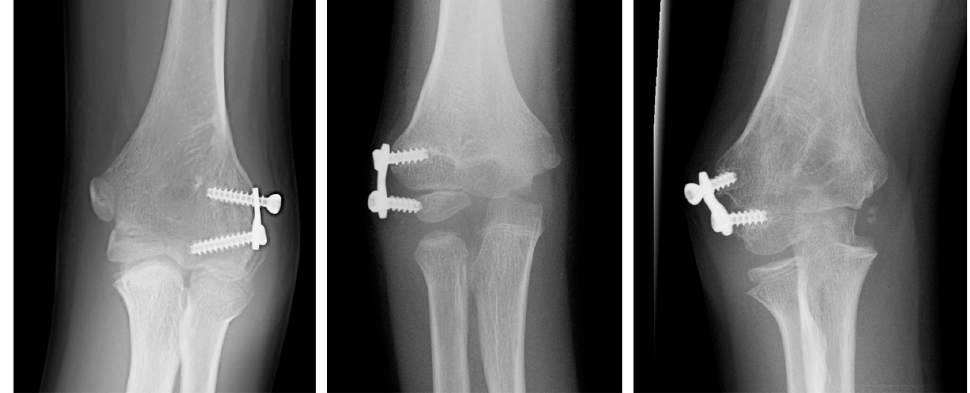
Figure 9. Radiographic images of some of the cases of aseptic loosening due to short screw length and a suboptimal technique in which the screws required replacement with longer and better-positioned screws.